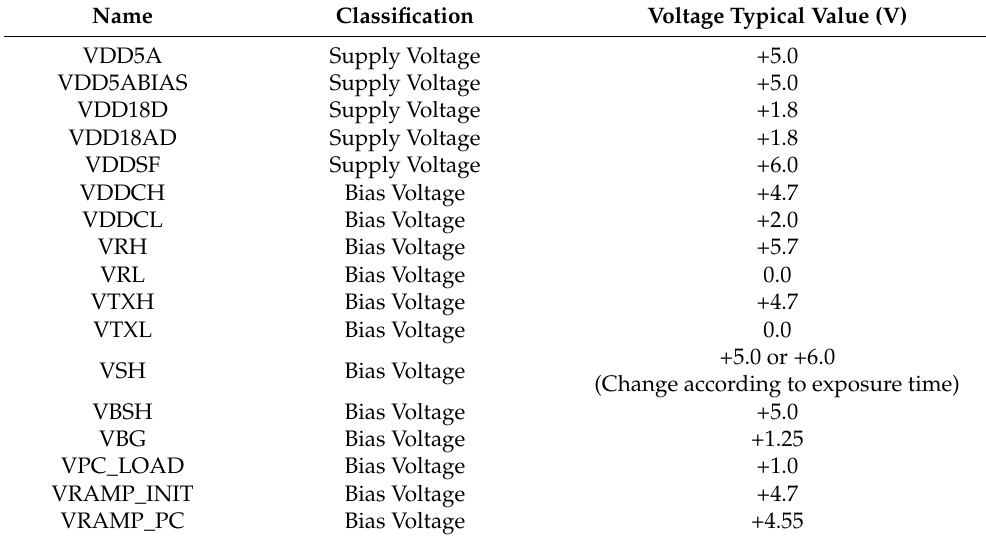
Table 3. Supply and bias power of CMOS